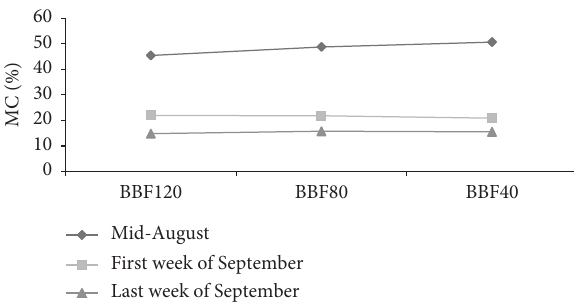
Figure 6: Soil moisture content (MC) of each drainage method at different dates of the growing